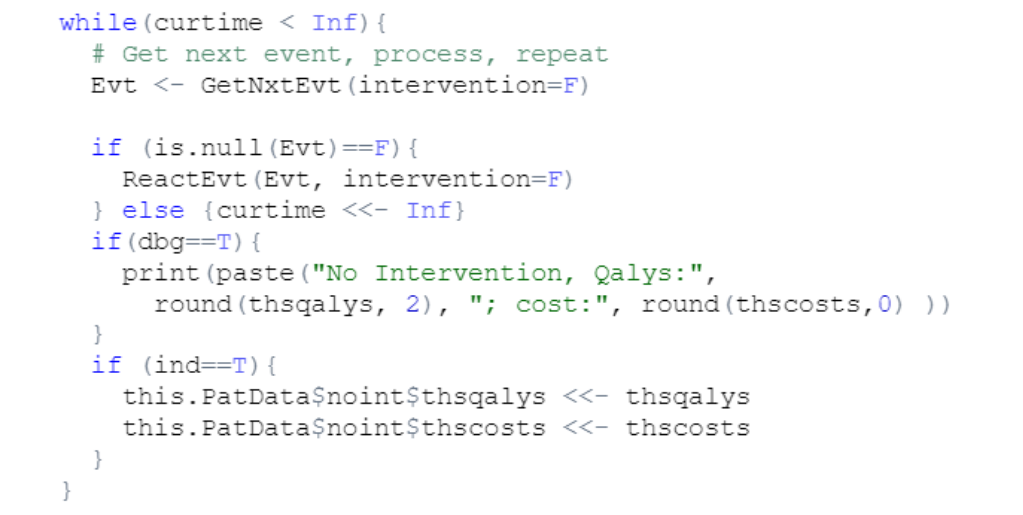
Figure A2. Code for selecting and processing the next event in the R version of the osteoporosis model.